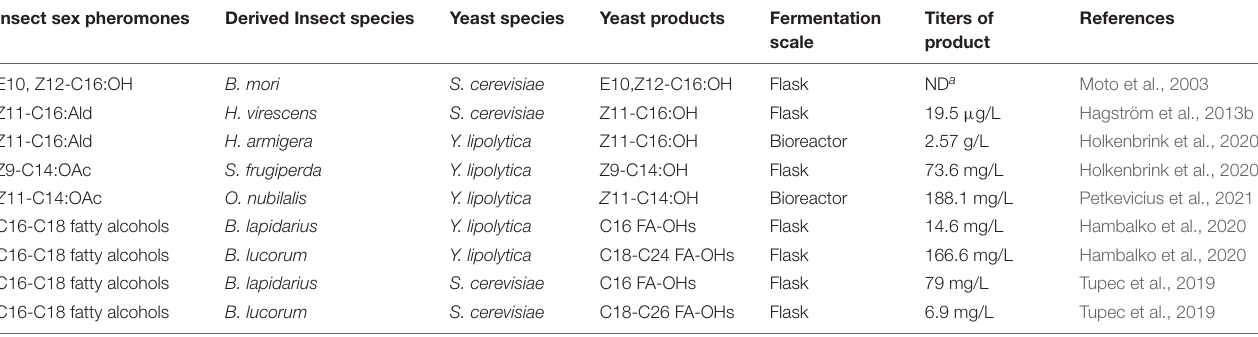
TABLE 1 | A summary of insect pheromones produced by various engineered yeasts. Insect sex